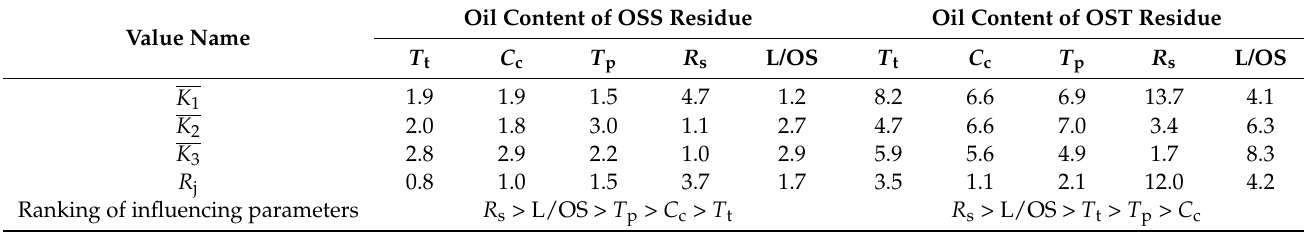
Table 5. Range analysis data of the oil content of residue.